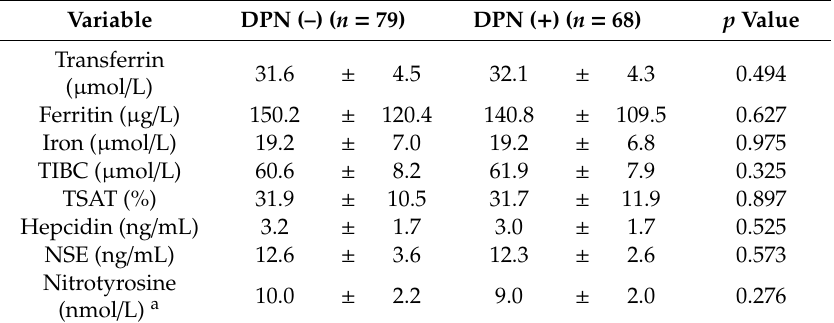
Table 5. Laboratory biochemical data of individuals according to the presence of